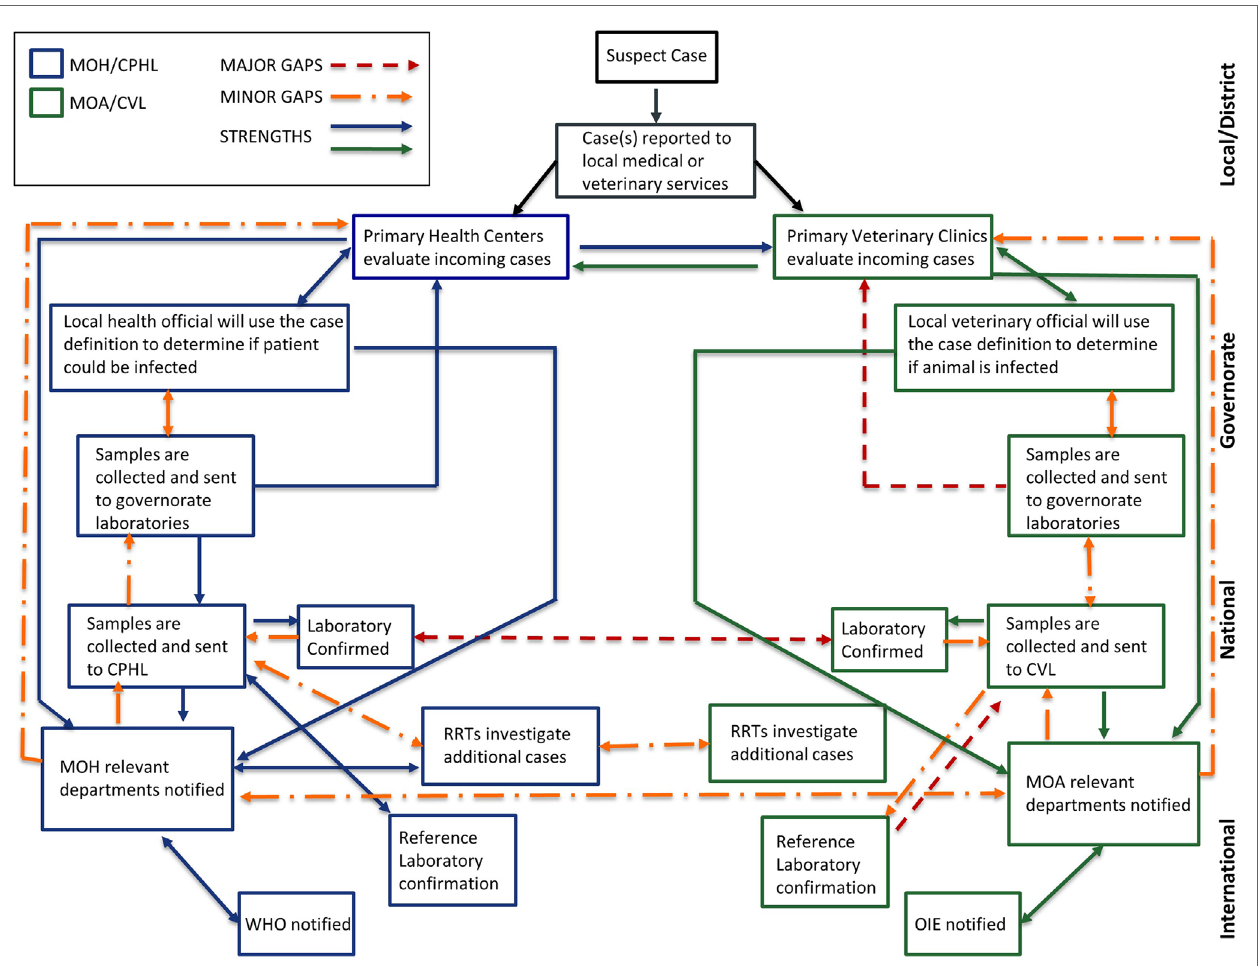
FigUre 6 | Mapping public health and veterinary surveillance and laboratory networks . An overall analysis of existing surveillance and laboratory networks for zoonotic diseases, including nodes of communication and response, were mapped across human health and veterinary sectors to indicate areas of strength and those requiring strengthening. Efforts in surveillance and response lead by Ministry of Health are represented in blue while those lead by Ministry of Agriculture are in green. Strengths within and across sectors are represented by solid blue and green lines. Major gaps are represented in red while minor gaps are represented in orange. Abbreviations: MOH, Ministry of Health; CPHL, Central Public Health Laboratory; DCD, Directorate of Communicable Diseases; MOA, Ministry of Agriculture; WHO, World Health Organization; OIE, World Organisation for Animal Health; RRTs, Rapid Response